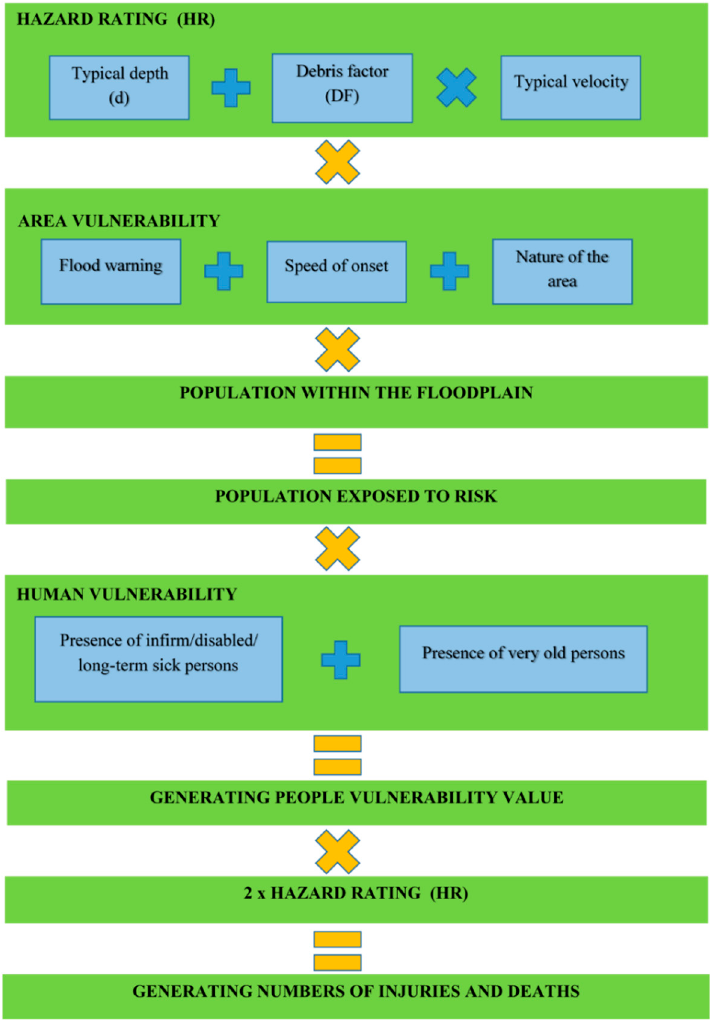
Figure 2. Overall scheme of the method to estimate the number of people injured and the number of fatalities caused by a flood. Own study based on